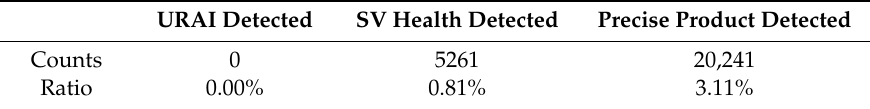
Table 3. Six-year BDS anomaly detection result using the URAI, SV health and the precise product.